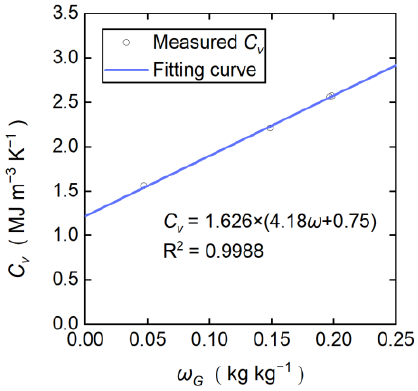
Figure 7. Fitting curve of the loess ρ b at a height of 12.5 cm.